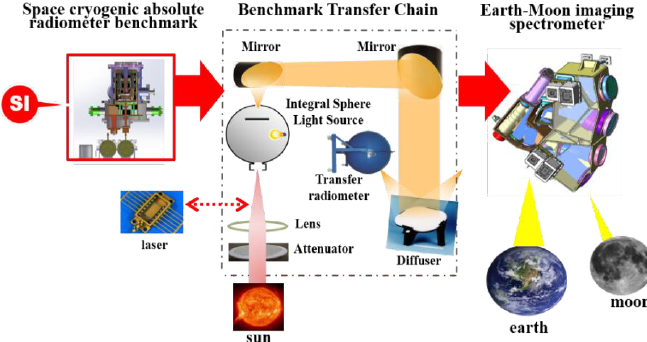
Figure 2. The principle of the radiometric benchmark on the reflected solar band.